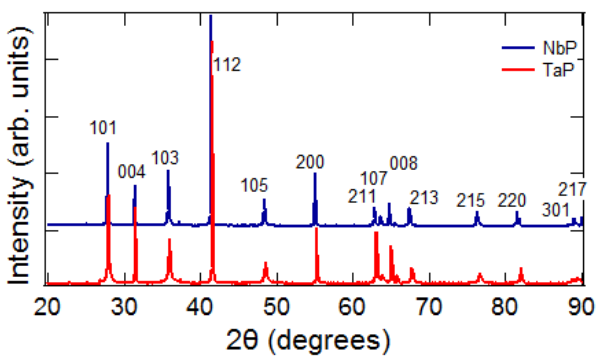
Figure 2. Room temperature X-ray diffraction pattern of NbP and TaP with reflections